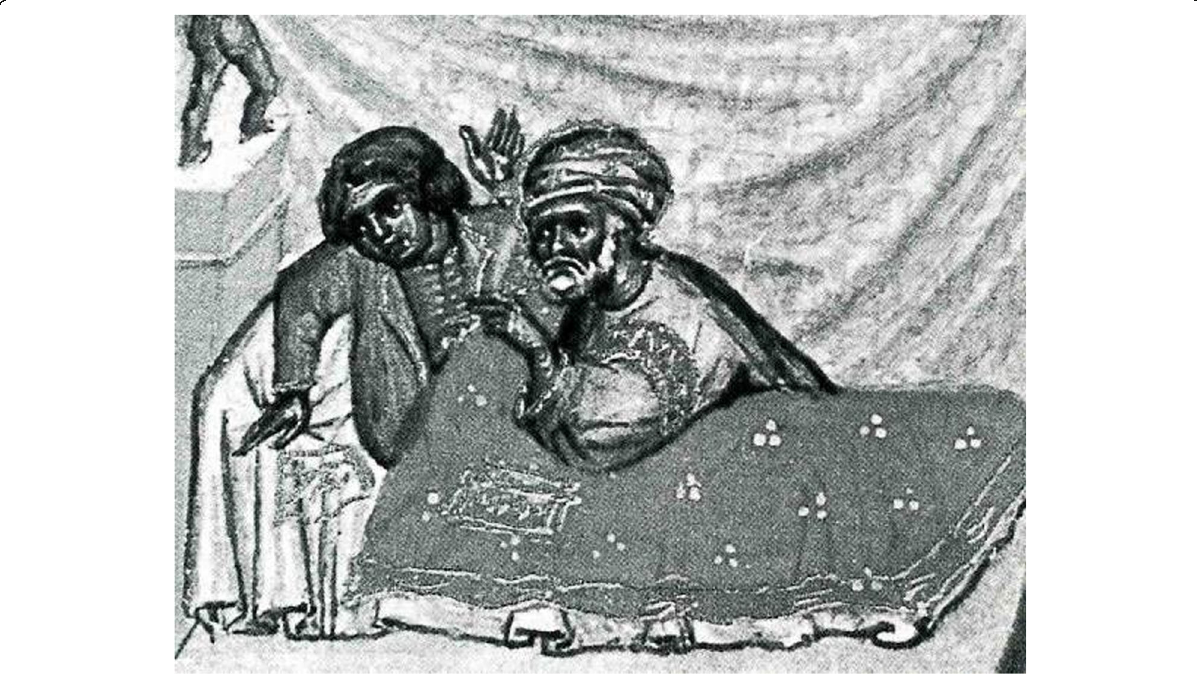
Fig. 1 Treatment of chronic apoplexy. Miniature from ABU ’ L Q Ā SIM, Codex Series Nova 2641, Fol. 6ra. Reprinted in: (1979) Chirurgia. Lateinisch von Gerhard von Cremona. Vollständige Faksimile-Ausgabe im Originalformat. Graz: Akademische Druck- u. Verlagsanstalt. With permission of Austrian National Library,